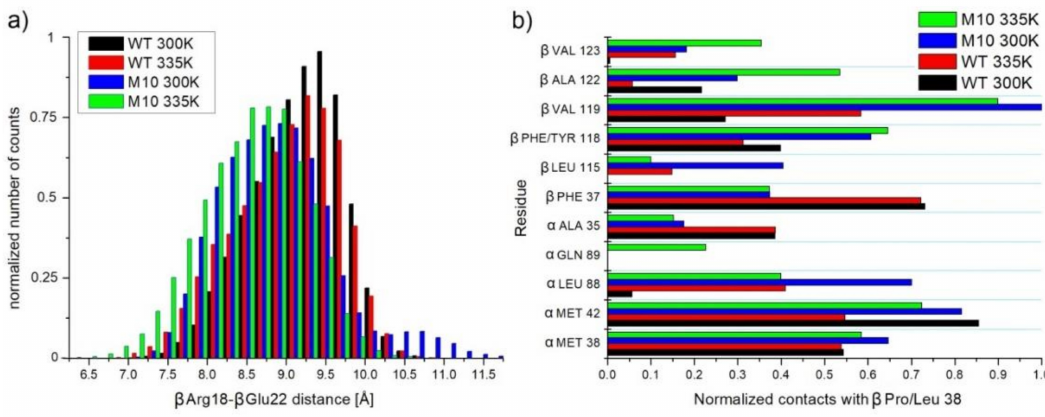
Figure 12. ( a ) Histogram of distances between C α atoms of β Arg18 and β Glu22. ( b ) Interactions of β Pro / Leu38 with neighbor amino